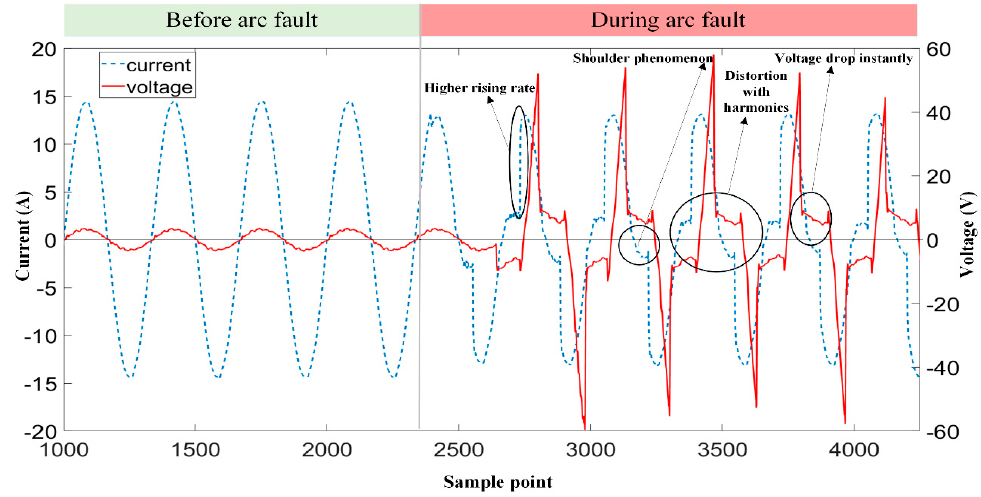
Figure 1. Voltage and current waveforms of series arc fault.